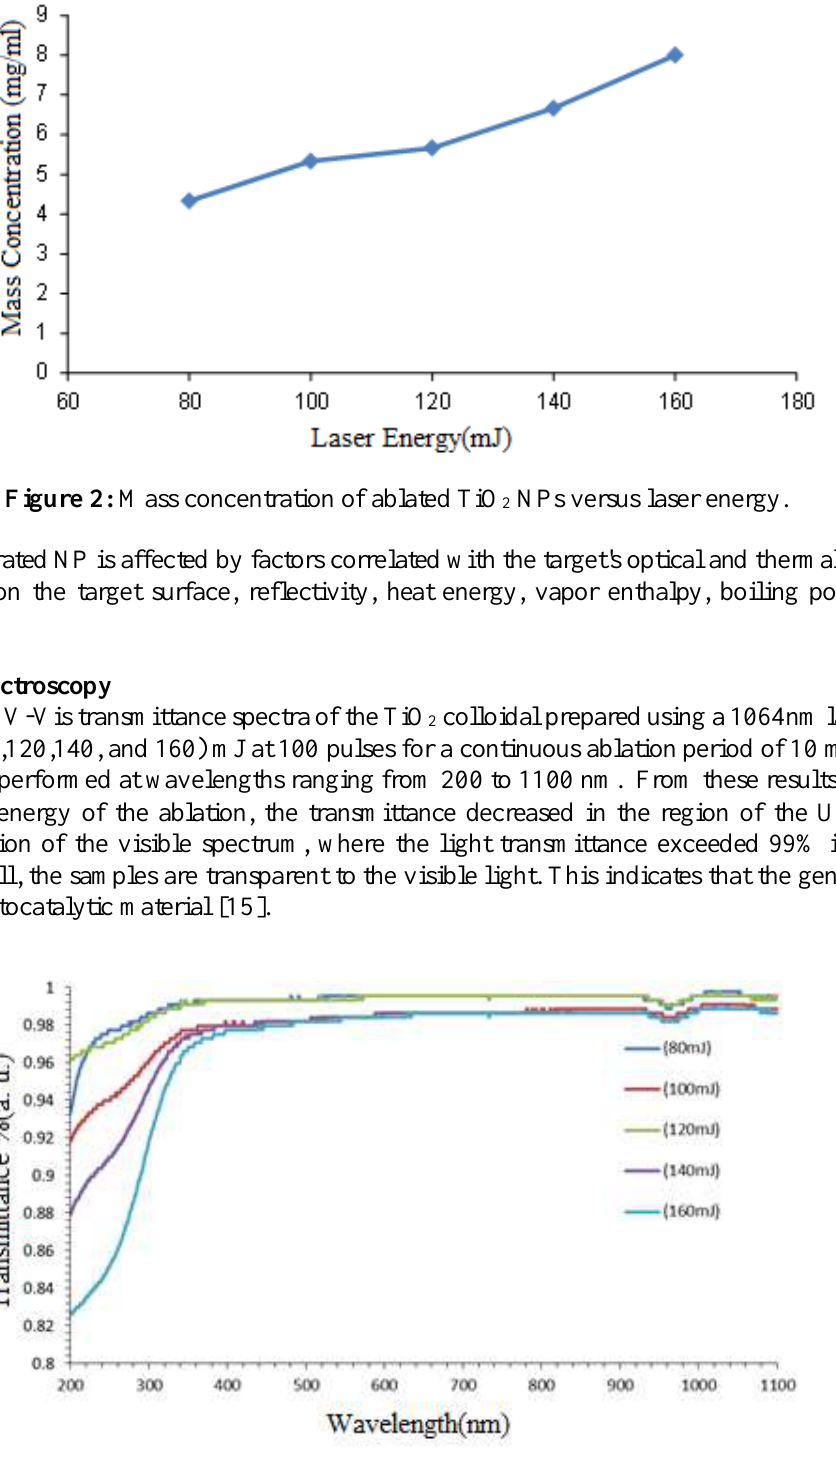
Figure 3: Transmittance spectra of the TiO 2 NPs colloidal synthesised with different laser energy at 100